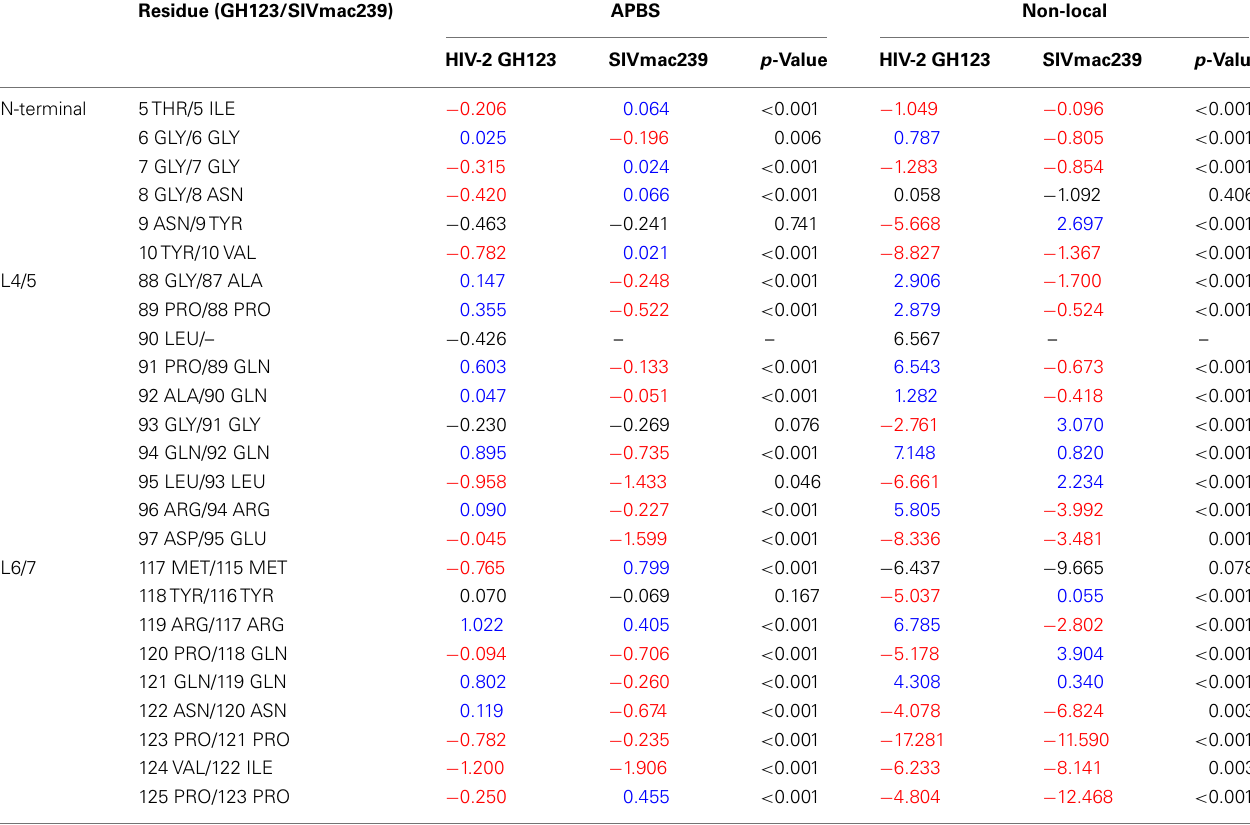
Color indicates significant difference (p < 0.05,Wilcoxon test) between the electrostatic potentials of the two molecules with positive electrostatic potential marked in blue and negative marked in